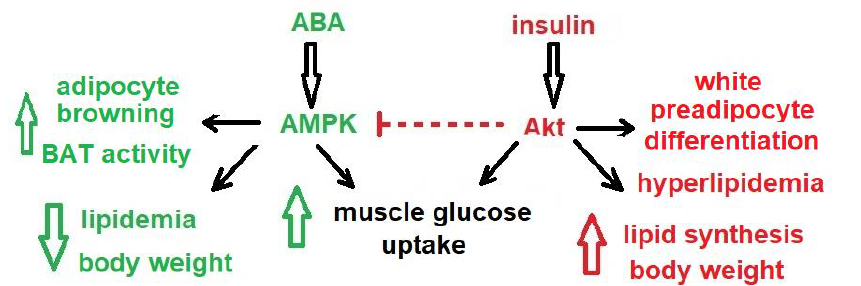
Figure 3. Non-overlapping roles of ABA and insulin in the regulation of energy metabolism. Insulin, via the kinase Akt, stimulates glucose uptake in skeletal muscle and white adipose tissue (WAT), triglyceride synthesis in adipocytes, preadipocyte di ff erentiation into WAT and increased hepatic triglyceride synthesis and lipoprotein export into the blood. Nanomolar ABA, via the AMP-dependent protein kinase (AMPK), stimulates muscle glucose uptake similarly to insulin, but the e ff ect on adipose tissue is di ff erent. ABA does not induce preadipocytes di ff erentiation; instead, it stimulates the expression of browning genes in the WAT and increases glucose uptake and mitochondrial uncoupling in brown adipose tissue (BAT). The e ff ect of insulin and of ABA on body weight (BW) is opposite, with insulin inducing an increase and ABA instead favoring a decrease. The relative plasma concentrations of these hormones is likely to a ff ect BW homeostasis and energy metabolism. Via Akt, insulin inhibits AMPK and the metabolic responses to low cell energy levels.